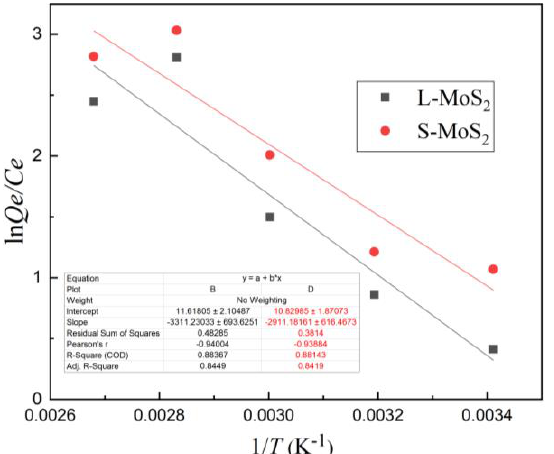
Figure 10. Thermodynamic model fitting for adsorption of Cu 2+ on S-MoS 2 and L-MoS 2 at different temperatures .